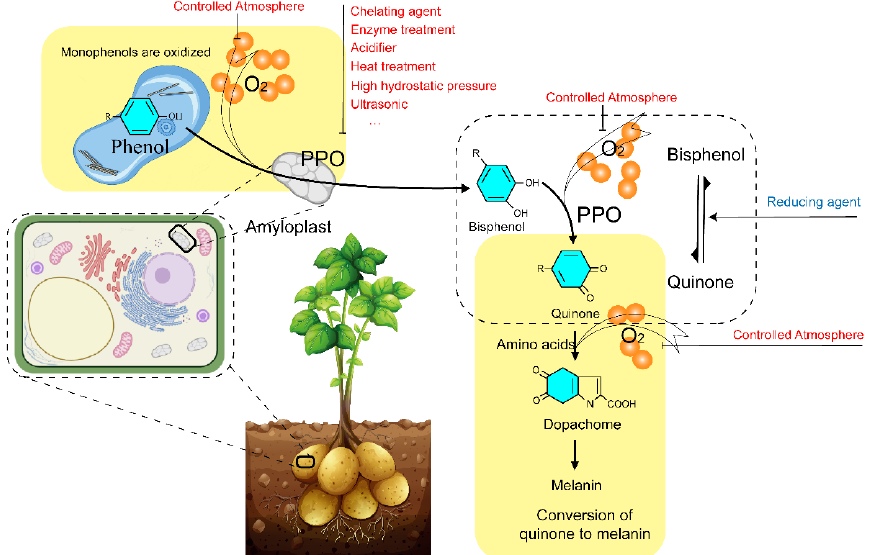
Figure 3. PPO in potato tubers is located in the amyloplasts, and phenols are present in the vesicles. Under oxygen conditions, the monophenols are oxidized by the activated PPO to bisphenols, which continue to be oxidized to quinones. Then quinones are converted to dopachome in the presence of amino acids and oxygen and further converted to melanin. Enzymatic browning can be inhibited by the control of oxygen, such as in a controlled atmosphere. Meanwhile, heat, enzymes, chemical treatment, etc. could decrease the biological activity of PPO and inhibit the enzymatic browning. The vector image of a potato plant was obtained from vecteezy.com. The cell pattern diagram is designed by biorender.com.